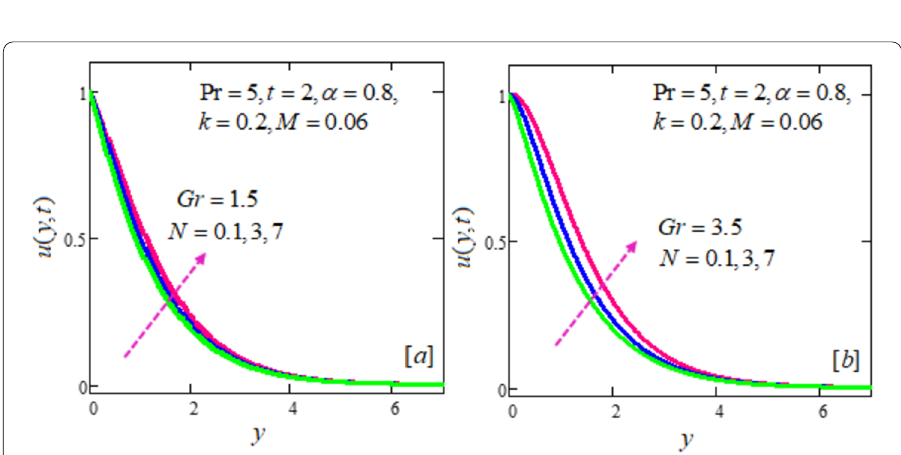
Figure 8 Velocity profile variation with radiation parameter N and Grashof number Gr